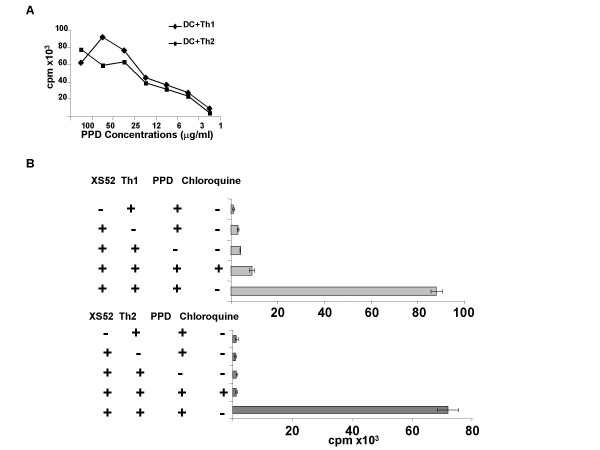
XS52 DC are capable of presenting native PPD effectively to T cells: (A) XS52 DC were γ-irradiated and then pulsed for 8 hr with the indicated concentrations of PPD. The PPD-reactive Th1 clone (diamonds) or Th2 clone (squares) (105 cells/well) was cultured for 2 days with PPD-pulsed XS52 cells (104 cells/well). (B) Following a 3 hr incubation with or without chloroquine (100 μM), XS52 DC were pulsed with PPD (100 μg/ml) in the presence or absence of chloroquine (100 μM) and then examined for their capacity to activate the PPD-specific Th1 and Th2 clones. Data shown are the mean ± SD (n = 3) of 3H-thymidine uptake. Baseline proliferation of γ-irradiated XS52 DC alone was <300 cpm.